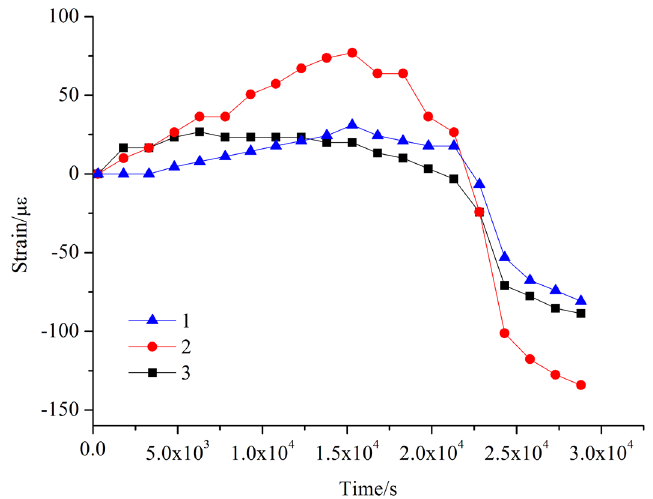
Figure 8. Strain–time relationship for concrete surface.